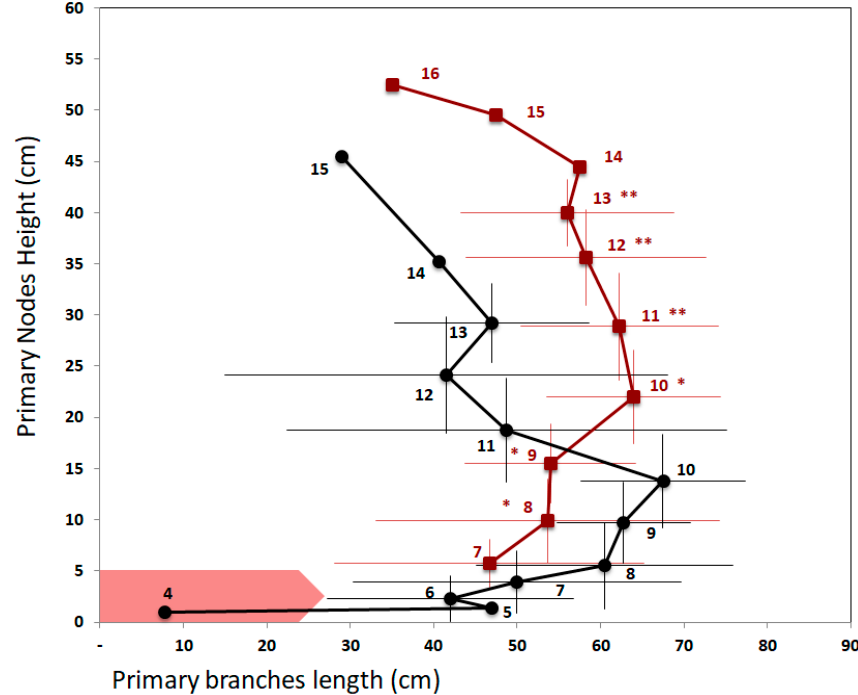
Figure 5. Profile of primary branch lengths according to node height on 15 May in Control (black) and FR-treated plants (brown). Numbers indicate the rank of the primary branch node. Horizontal and vertical bars represent the standard deviation calculated for n ≥ 3. The red arrow indicates the position of the FR-LED rings located between 0 and 5 cm. The node heights between Control and FR treatments were compared node by node using Kruskal–Wallis test: ** p < 0.05; * 0.05 ≤ p ≤ 0.10. Branches of the Control plants were no longer than those of the FR-treated plants except above 20 cm height (Student test: p = 0.0032).